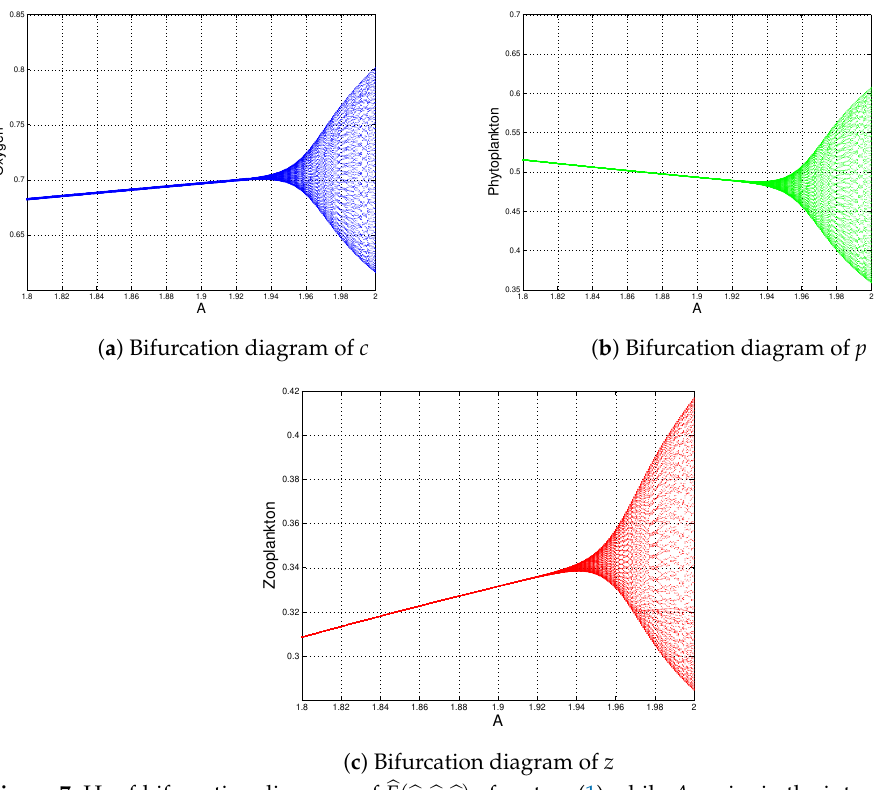
Figure 7. Hopf-bifurcation diagrams of (cid:98) E ( (cid:98) c , (cid:98) p , (cid:98) z ) of system (1) while A varies in the interval [ 1.8,2 ] and the others remain unchanged as in Figure 6. Here, A = A [ H ] 1 = 1.966532.